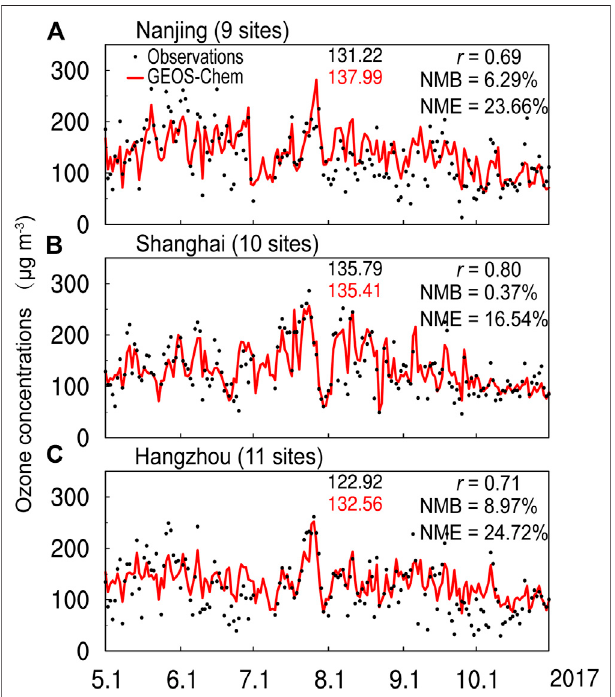
FIGURE 3 | Differences in monthly mean daily maximum 8 h average (MDA8) ozone concentrations ( μ g m − 3 ) between sensitivity simulations with reduced anthropogenic NO x (left two columns) or VOCs (right two columns) emissions and the standard model simulation from May to October 2017.AnthropogenicNO x orVOCsemissionsintheYangtzeRiverDelta(YRD) region reduced by 20 and